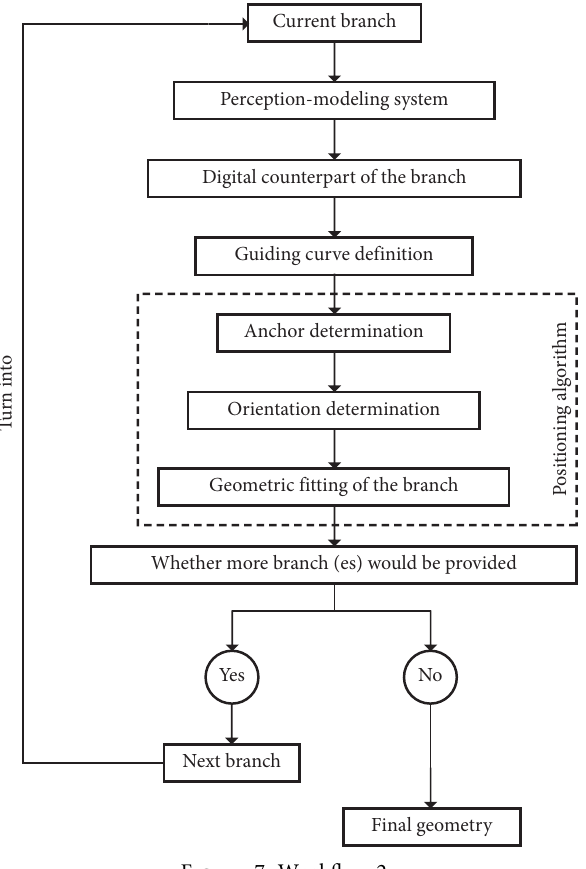
Figure 7: Workflow